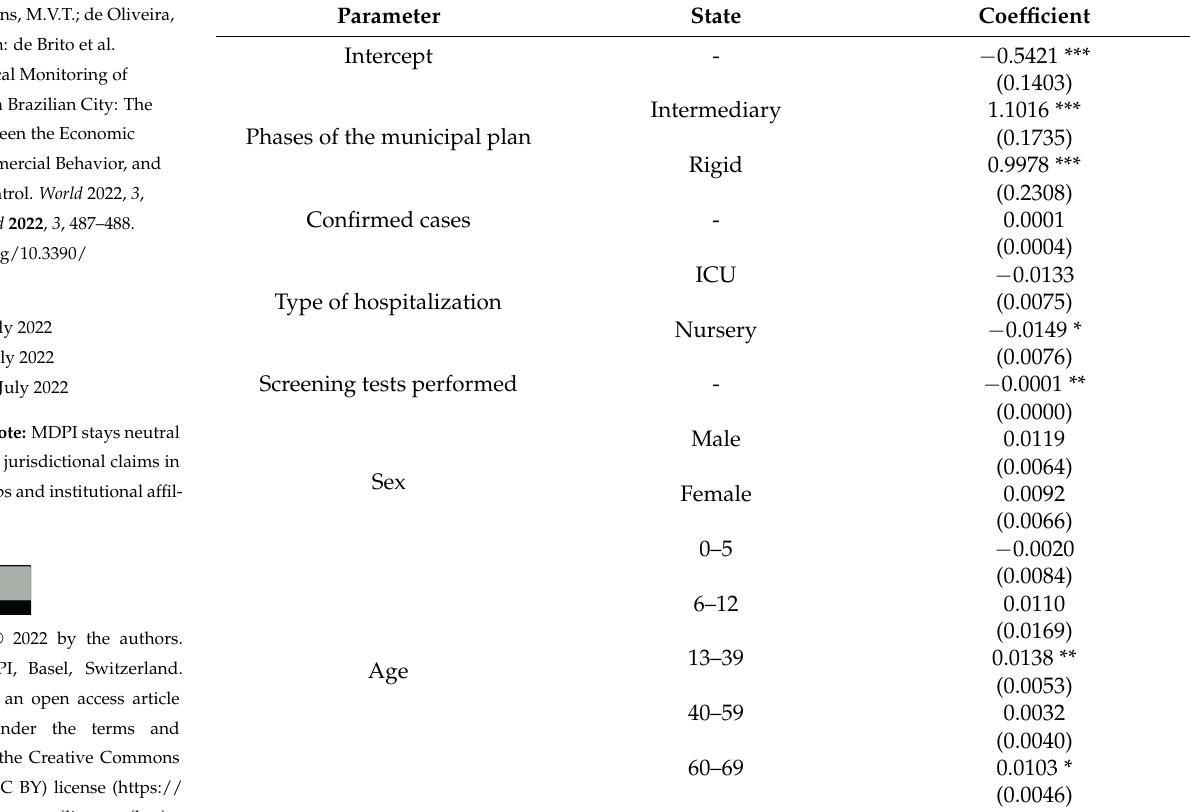
Table 3. Poisson model data referring to COVID-19 notifications to the Municipal Health Department of Uberl â ndia